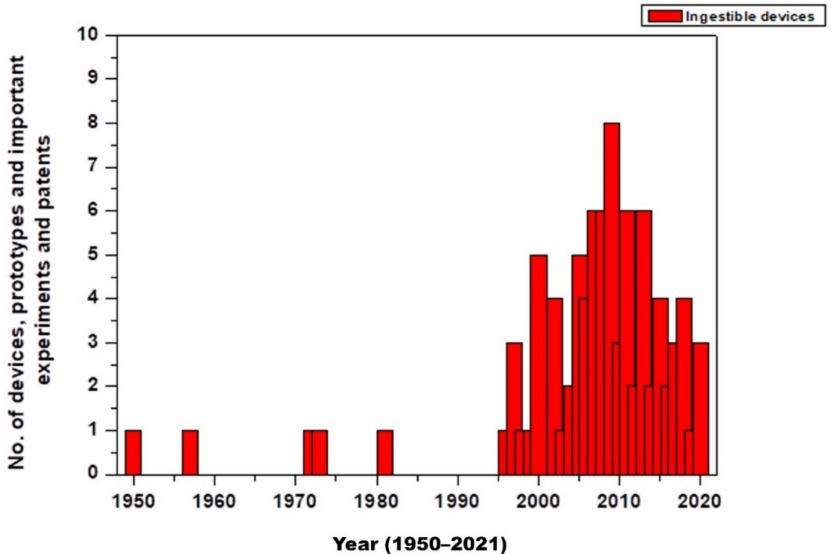
Figure 2. No. of devices, prototypes, important experiments, and patents